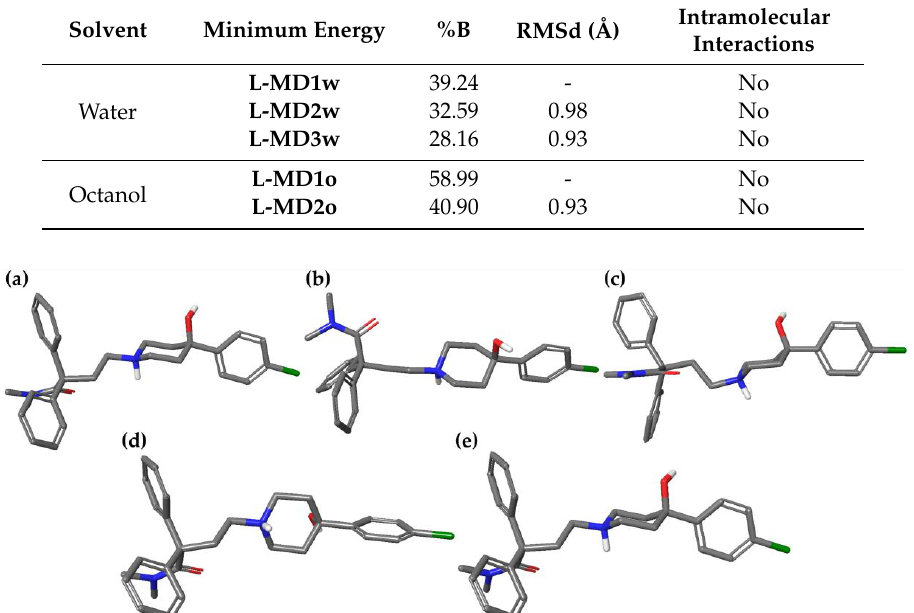
Table 5. % B, RMSd values and intramolecular interactions of the most probable energy minima for loperamide, obtained after the minimization of all MD frames in both solvents. RMSd values are reported in Å, and they are calculated on the heavy atoms of loperamide compared to the global energy minima ( L-MD1w and L-MD1o ).